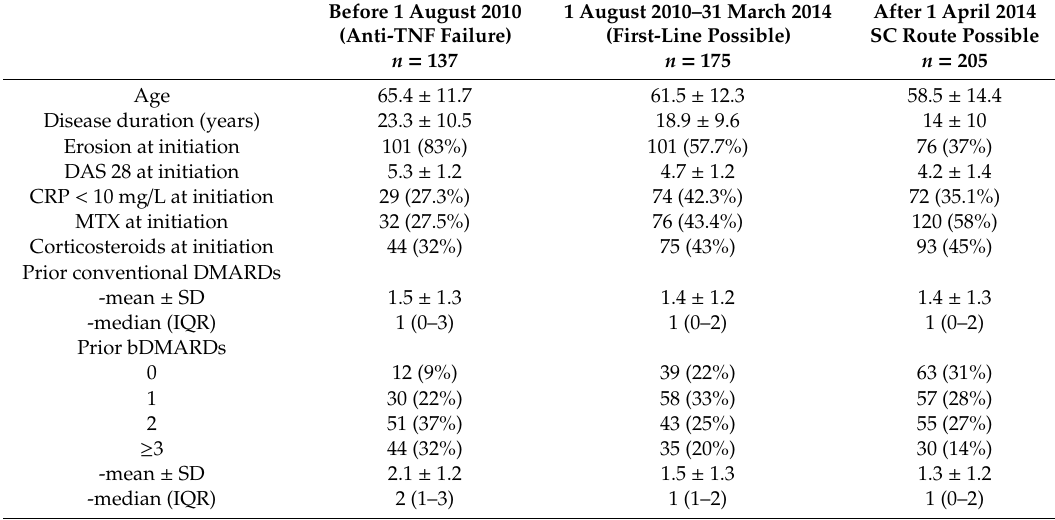
Table 3. Patient characteristics according to the date of abatacept